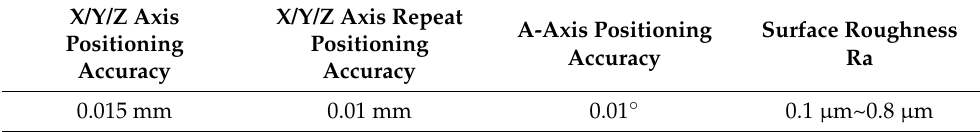
Table 2. Chemical composition and mechanical properties of GH4169